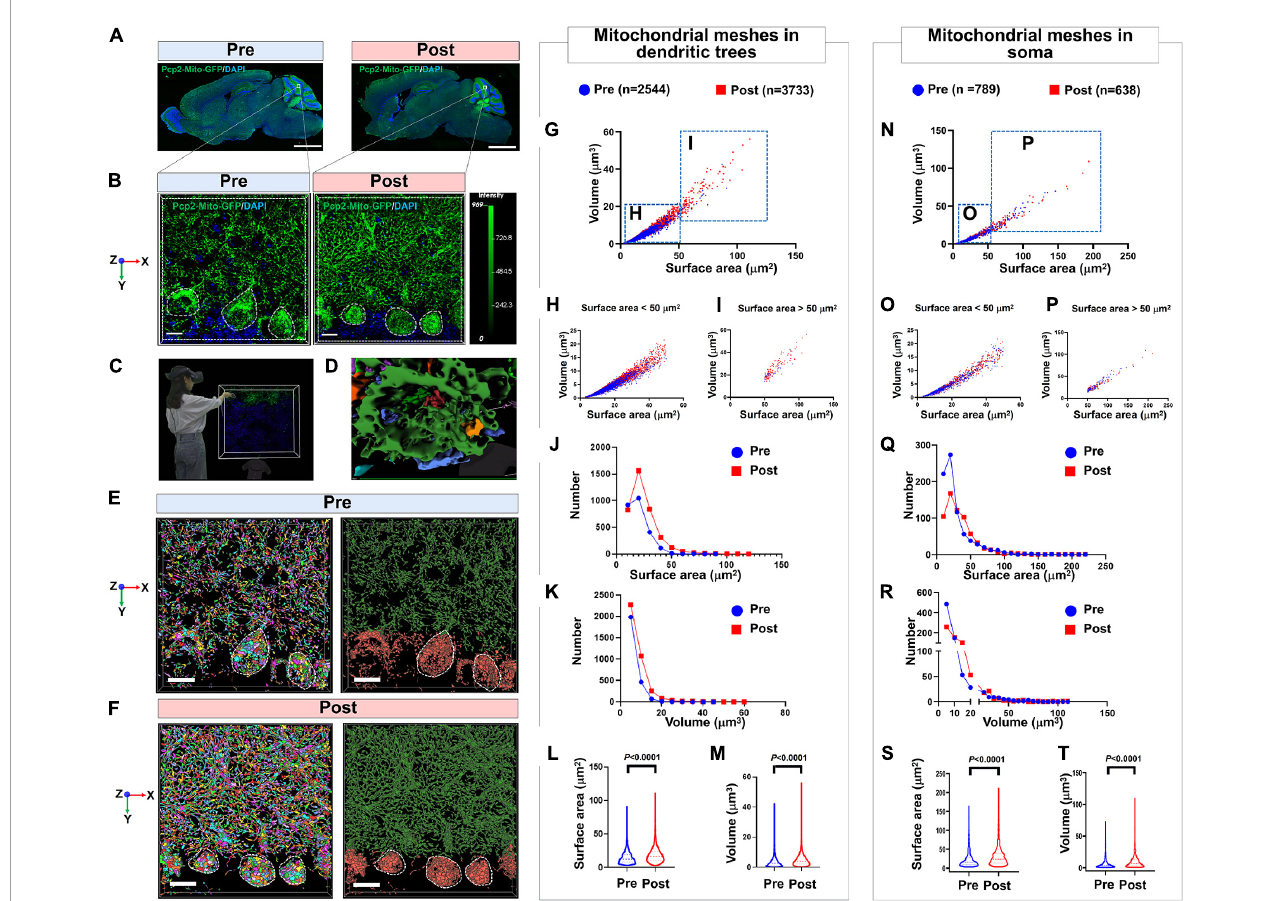
FIGURE5 Confirmation of the mitochondrial mesh hypothesis by using the model of simulating long-term pilot flight. (A) Panoramic view the whole brain of PCs-Mito-GFP mice before or after the treatment of overweight centrifugal force. Bar = 1 mm. (B) Magnification of PCs from panel (A) . Bar = 5 µ m. (C) 3D reconstruction view is observed by immersive VR. (D) The magnification showing the meshes in soma of PC. Bar = 20 µ m. (E,F) The quantity of mitochondria in dendritic trees and soma from PCs-Mito-GFP mice increases sharply after treatment with overweight centrifugal force. Bar = 5 µ m. (G) Scatter diagram of mitochondrial mesh in dendritic trees of PCs. (H,I) Scatter diagram of mitochondrial mesh, whose volume is smaller than 50 µ m 3 (H) or larger than 50 µ m 3 (I) , in dendritic trees of PCs. (J,K) Frequent distribution showing the surface area (J) and volume (K) of mitochondrial mesh in dendritic trees of PCs. (L,M) Quantification showing the surface area (L) and volume (M) of mitochondrial mesh in dendritic trees of PCs. The surface area and volume of mitochondrial mesh in dendritic trees of PCs increased remarkably after treatment with overweight centrifugal force. (N) Scatter diagram of mitochondrial mesh in soma of PCs. (O,P) Scatter diagram of mitochondrial mesh, whose volume is smaller than 50 µ m 3 (O) or larger than 50 µ m 3 (P) , in soma of PCs. (Q,R) Frequent distribution showing the surface area (Q) and volume (R) of mitochondrial mesh in soma of PCs. (S,T) Quantification showing the surface area (S) and volume (T) of mitochondrial mesh in soma of PCs. The surface area and volume of mitochondrial mesh in soma of PCs increased remarkably after treatment with overweight centrifugal force. Mann-Whitney U -test was used for statistical analysis. The data are shown as the mean ±